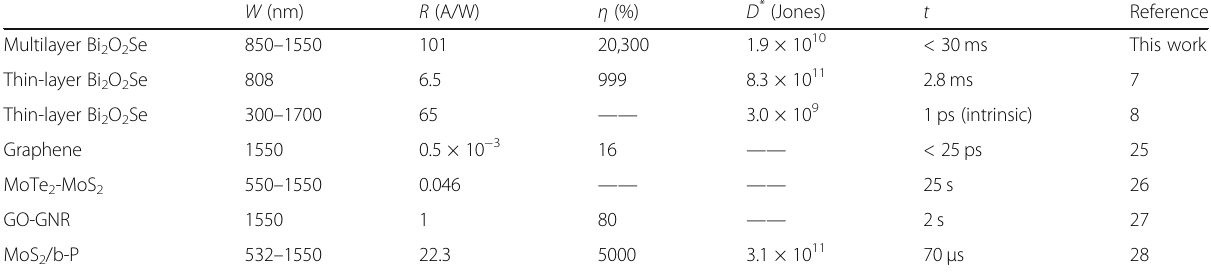
Table 1 Comparison of the performance of different room temperature NIR photodetectors. W represents response wavelength, R represents the photoresponsivity, η represents the external quantum efficiency, D * represents detectivity, and t represents response time W (nm) R (A/W)